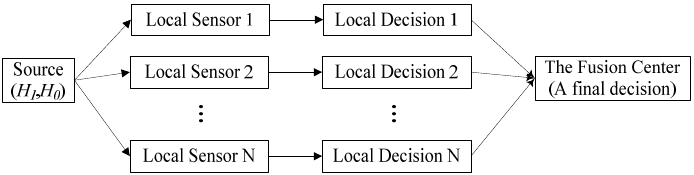
Figure 1. A typical distributed detection system with multiple sensors.